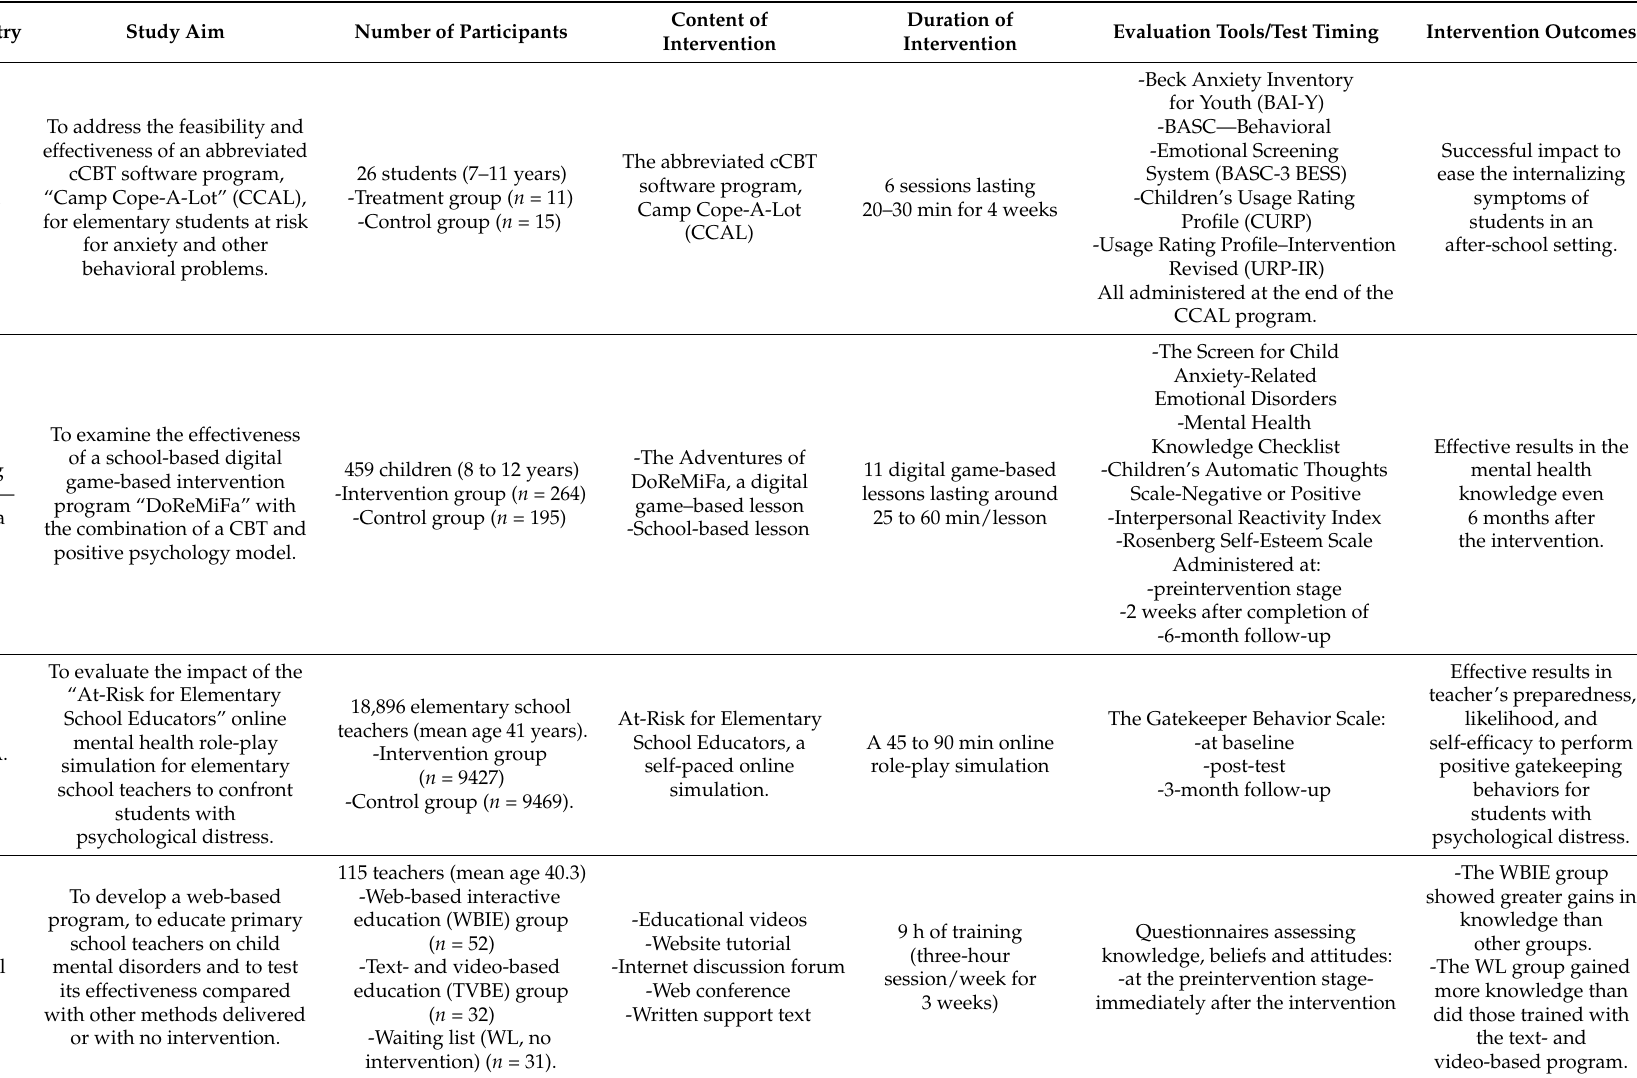
Table 2. Review of final six